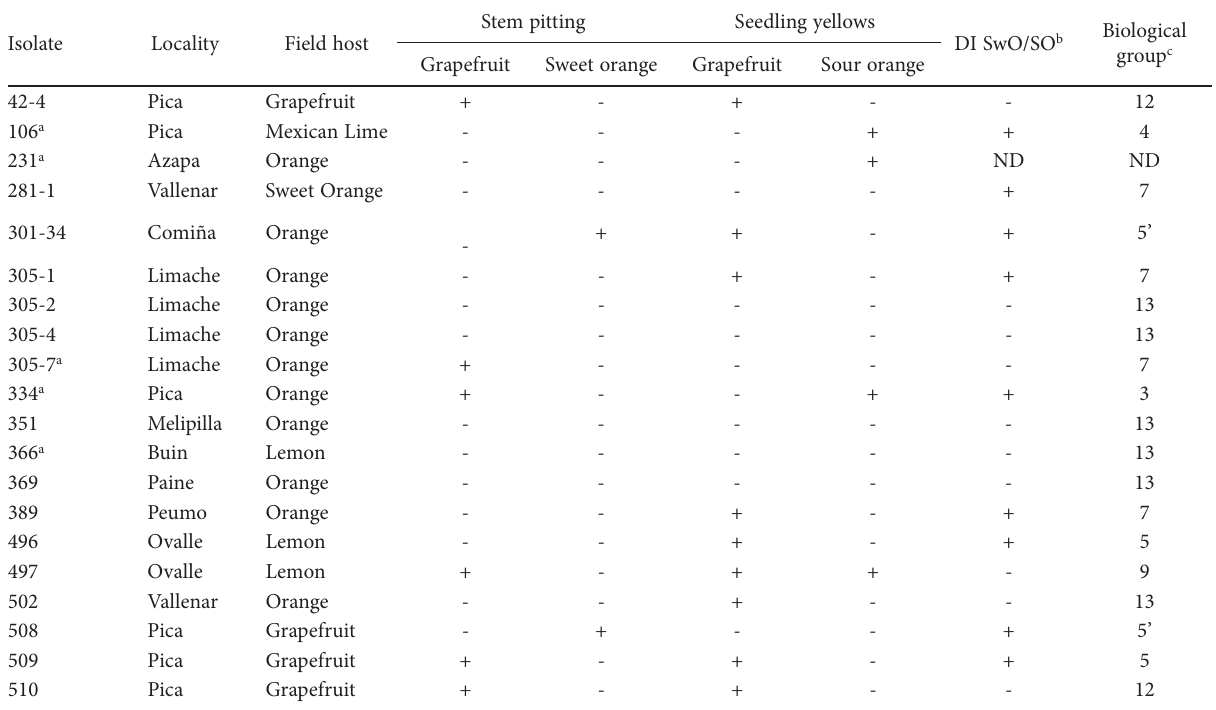
Table 1. Biological characterization of Chilean CTV populations used in this study.